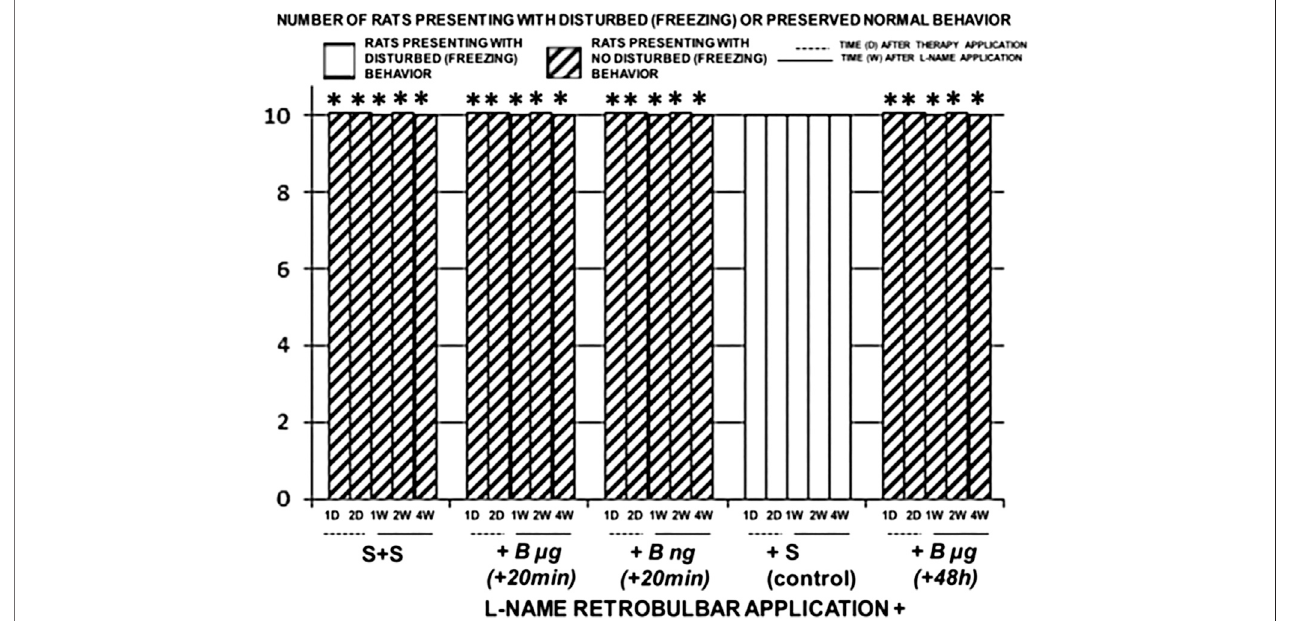
FIGURE 9 | Retrobulbar L-NAME application induced retinal damage. Rats behavior presentation after retrobulbar agent ’ s application. Left. Saline retrobulbar application(s) completely preservedratsbehaviorandtheydid notpresentfreezingbehaviorwhileinvestigated(S+S).Right.L-NAMEretrobulbarapplication(total dose 5 mg/kg, which was divided by the retrobulbar application in each eye, 0.5 mg/0.1 ml saline/eye) (L-NAME retrobulbar application +). Rats underwent L-NAME that receivedBPC157therapy(totaldose10 μ g/kgor10 ng/kgasretrobulbarapplicationineacheye,1 μ g/0.1 mlsaline/eyeor1 ng/0.1 mlsaline/eye)at20 min[B μ g (+20 min),B ng(+20 min)],or48 h[B μ g(+48 h)].Ratspresentedbehaviorwithoutanyfreezingbehavior.RatsunderwentL-NAMEthatreceivedsalineastherapy[saline only as retrobulbar application in each eye (0.1 ml/eye)] [since no different the rats underwent L-NAME that received saline retrobulbar application were presented together (+S (control)]. Rats continuously presented mostly freezing behavior while investigated. * p < 0.05, at least vs. control. 10 rats per experimental group and period for all